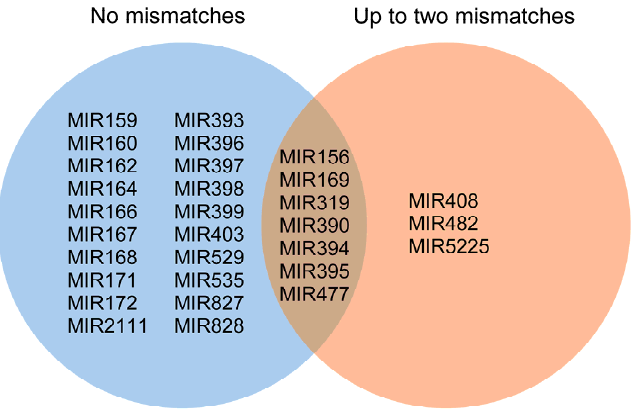
Figure 1. Families of miRNAs to which belong predicted hop miRNAs that align with known miRNAs deposited in miRBase. Hop miRNA families with members that align without mismatches are in the blue circle (20 miRNA families) and those that align with up to two mismatches are in the orange circle (3 miRNA families). Seven families comprise members that align perfectly or with up to two mismatches.